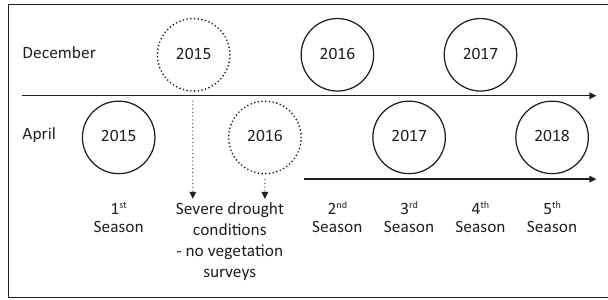
FIGURE 1: Survey events timeline: First season represented by April 2015; December 2015 and April 2016 no sampling because of lack of vegetation; second season represented by December 2016; third season represented by April 2017; fourth season represented by December 2017; and fifth season represented by April